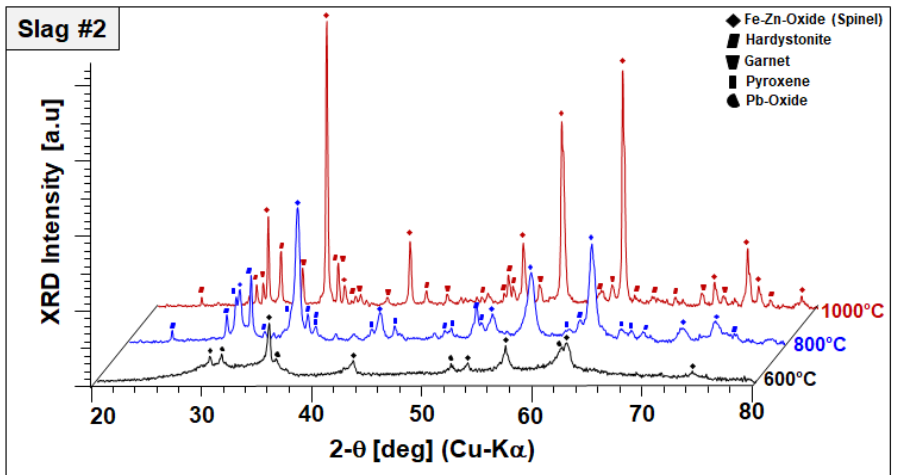
Figure 6. XRD profiles and co-existing crystalline phases of slag 2 after annealing for 2 h in